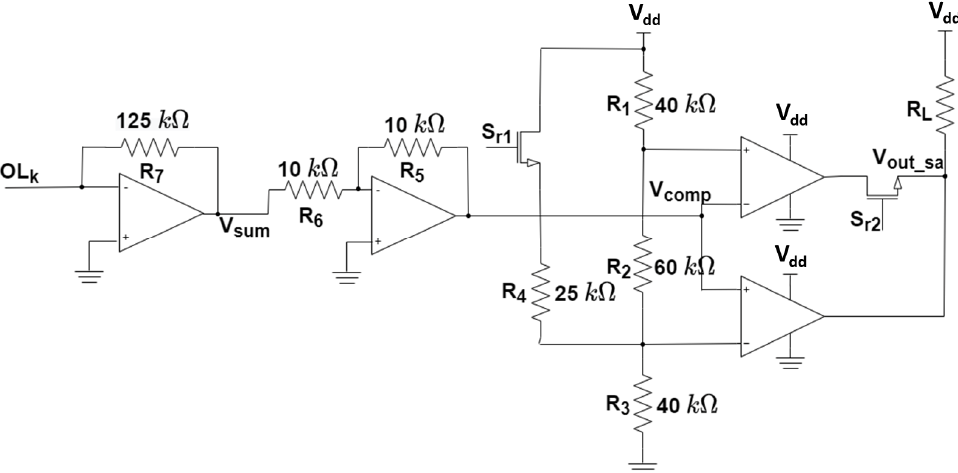
Figure 4. Circuit schematic of an alternative voltage-based sense amplifier for scouting logic. It consists of a summing amplifier, an inverting amplifier, and a configurable comparator stage (far right side of the schematic). Resistor values were selected based on simulation results, assuming 2-input AND/OR/XOR logic operations and memristors with HRS/LRS = 125 G Ω /125 K Ω .